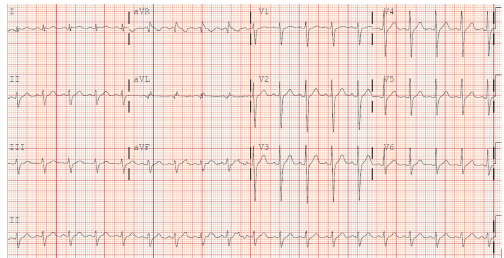
Figure 1: ECG sinus tachycardia. Left axis deviation late precordial lead